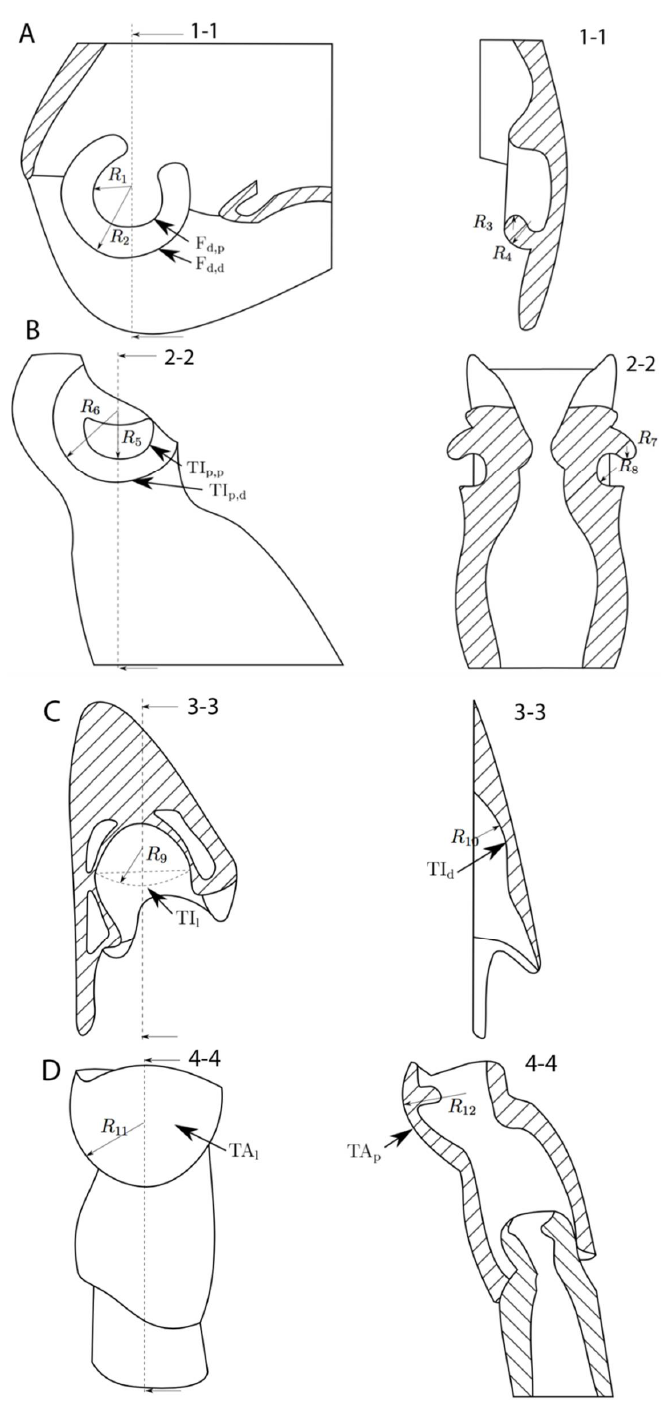
Figure 4. Schematic of the geometry of ( A , B ) the femur–tibia and ( C , D ) the tibia–tarsus leg joints of P. marginata . These schemes are based on three-dimensional analyses using confocal laser scanning microscopy (CLSM) and microcomputer tomography (μCT). The dashed lines show the position of section view. The filled areas represent the cross section of cuticle. F d,p : the distal end of the femur, the proximal condyle; TI p,p : the proximal end of the tibia, the proximal condyle; F d,d : the distal end of the femur, the distal condyle; TI p,d : the proximal end of the tibia, the distal condyle; TI d : the distal end and the condyle of the tibia; TA p : the proximal end and the condyle of the tarsus; TA l : the lateral curvature of the tarsus condyle; R 1–12 : radii of contacting joint surfaces; 1-1 to 4-4: sectional views of the geometry of the joints.